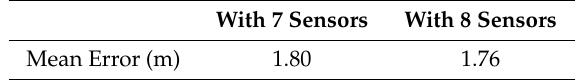
Table 4. Mean error comparison for different arrangements of sensors.